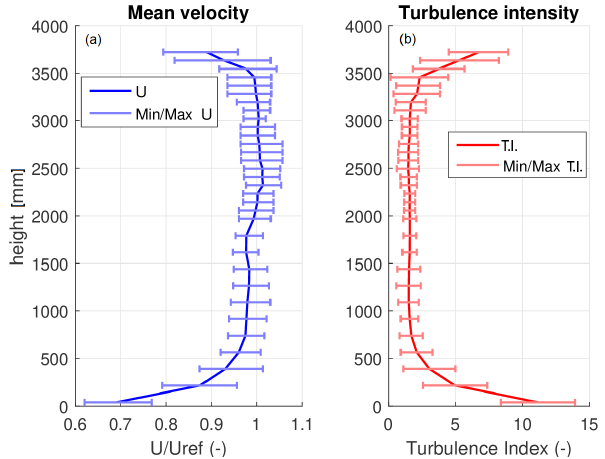
Figure 2. Wind tunnel speed and TI profiles normalized by the value measured at hub height with error